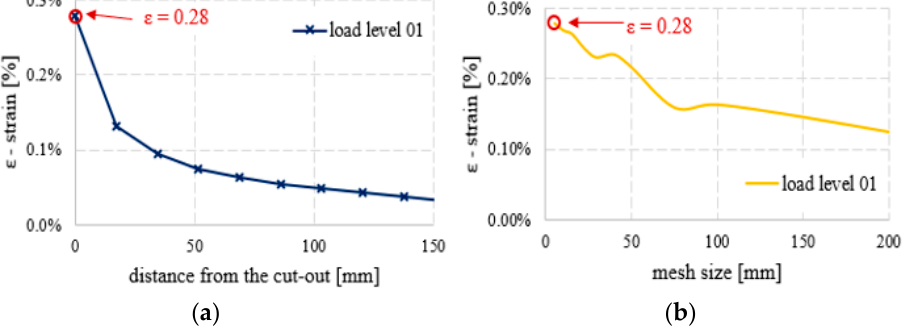
Figure 11. Strains at design load level, ( a ) depending on the distance from the cut-out, ( b ) maximum values depending on the mesh size.